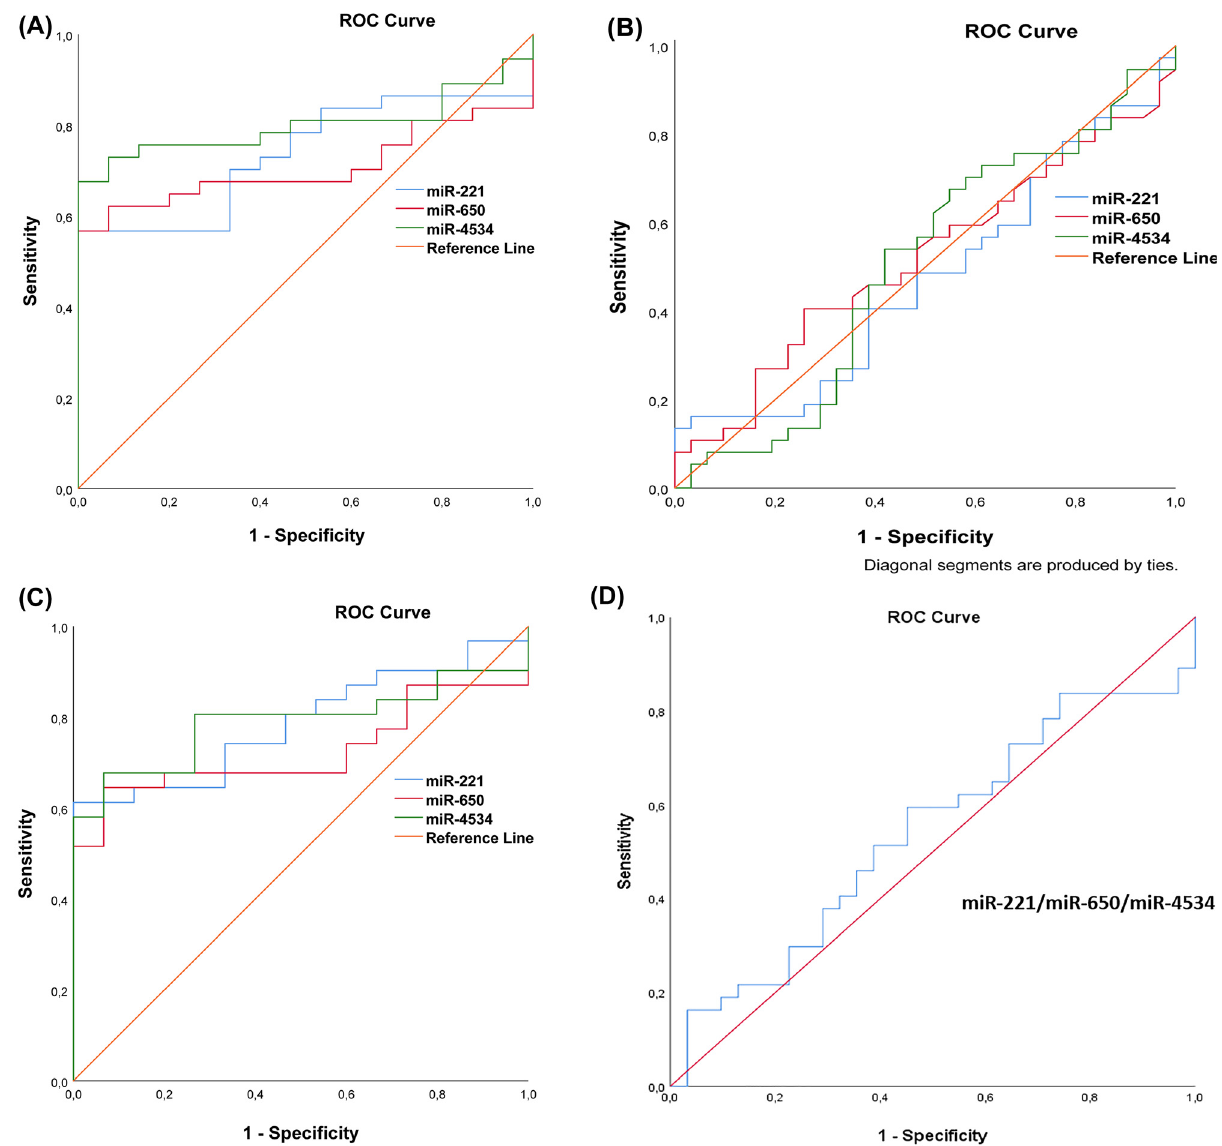
Figure 3: ROC curve showing expression levels of differential miRNAs. ROCanalysesforthediscriminationofmiRNAlevelsinpatientswithPCaandHC(A),inpatientswithPCaandBPH(B),inpatientswithBPHand HC (C), multimarker ROC analysis in patients with PCa and BPH (D). ROC curves were created using the Δ Ct